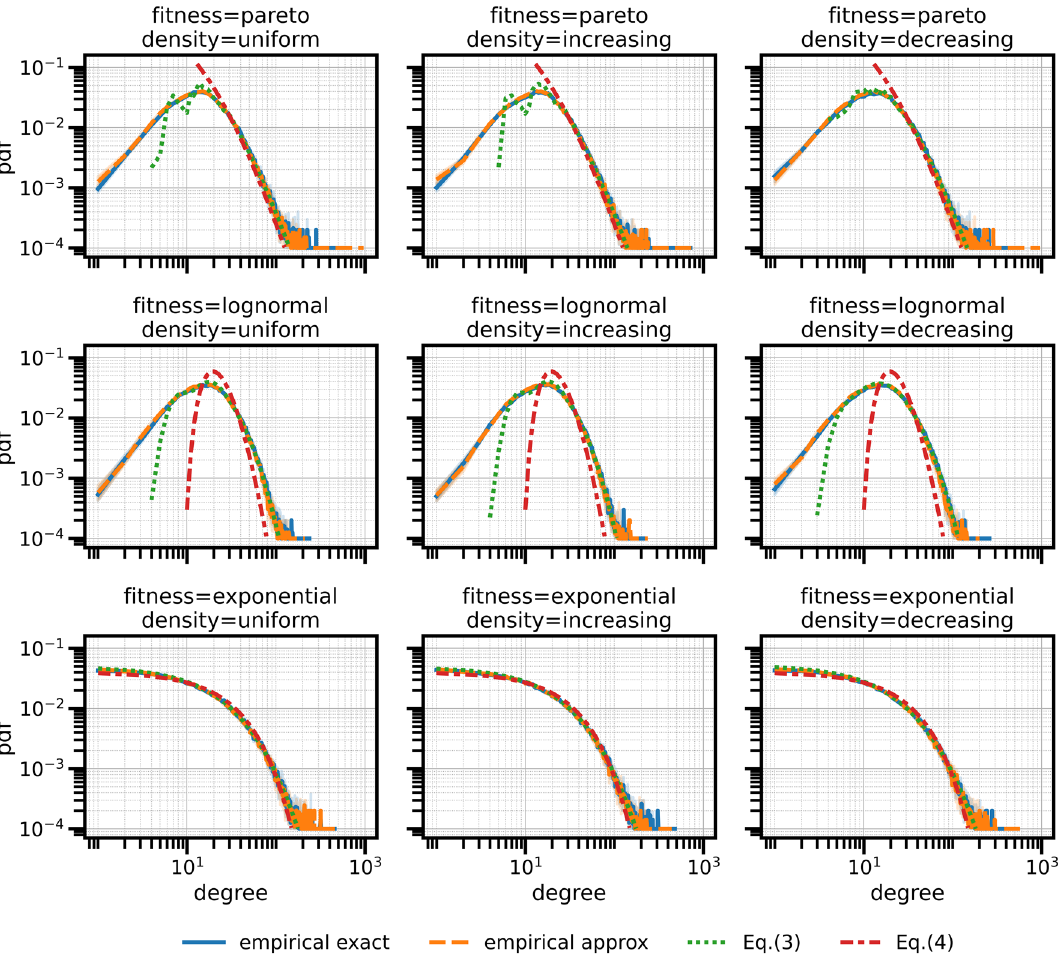
Figure 1. The degree distribution for an ideal city (circular, 10K inhabitants) for 3 different densities (uniform, radial increasing, radial decreasing) and 3 different fitness distributions (powerlaw, lognormal,